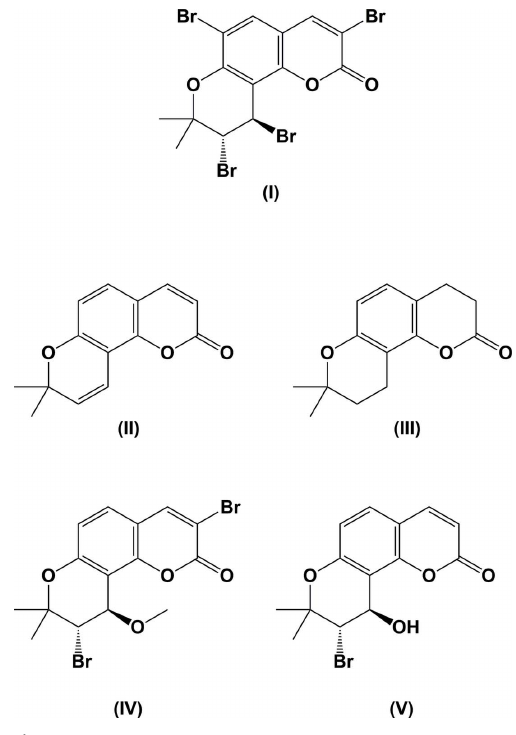
Figure 1 The title compound and related